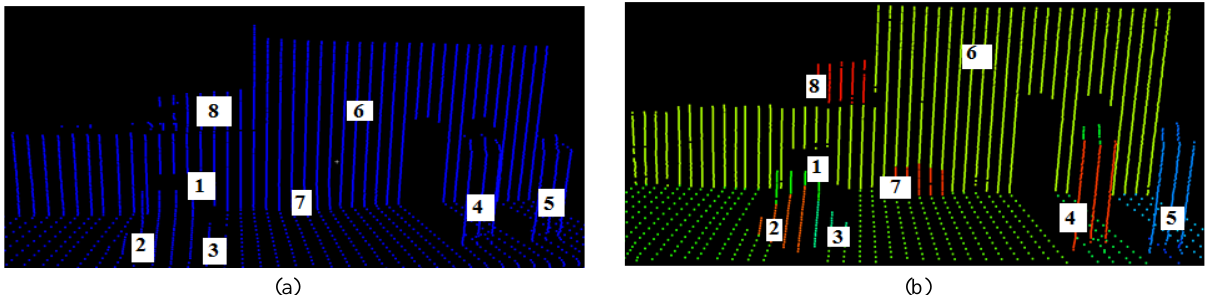
Figure 5. RGPL result for dataset 2: (a) point cloud; (b) final result. Different regions are indicated by different